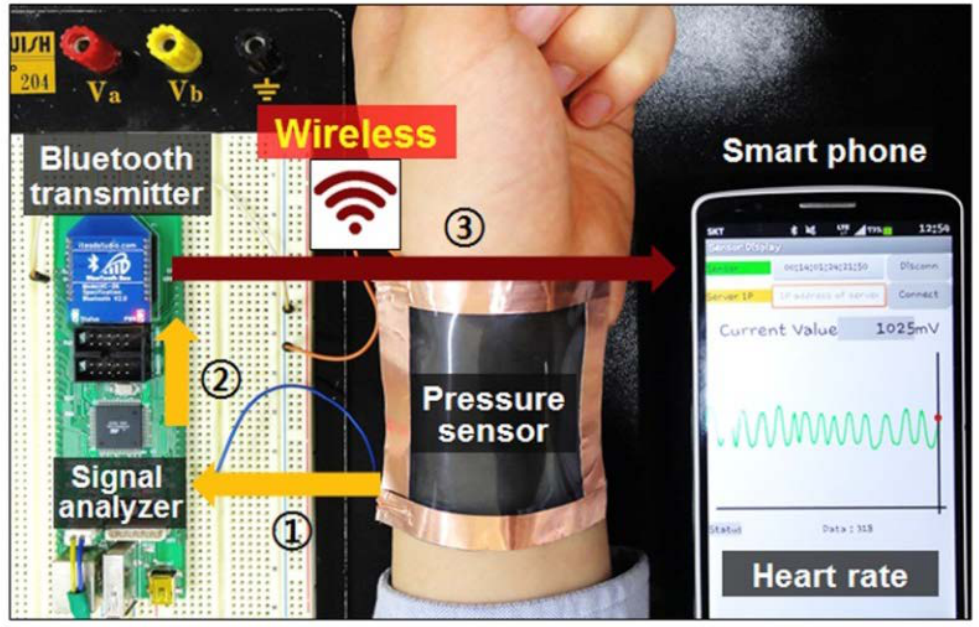
Figure 11. Photograph of wearable and wireless pressure sensor for heart rate monitoring [147].